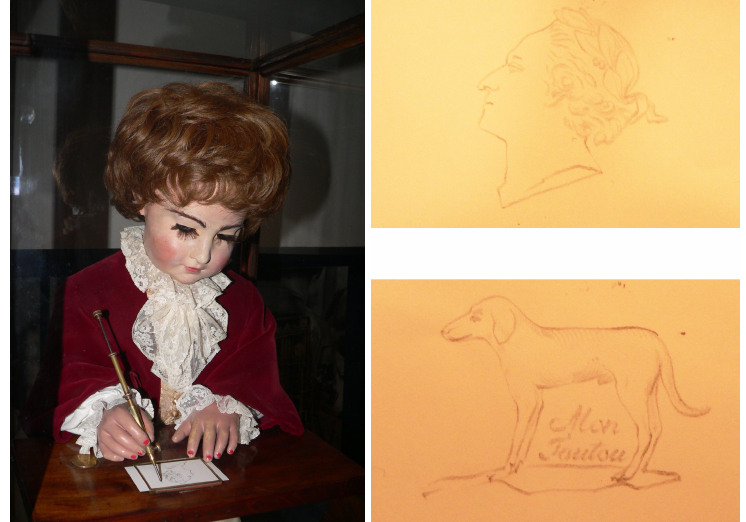
Figure 1. The “Artist” painting automaton by Jaquet-Droz ( Left , Rama (2005)) along with two of the four images that it can draw: a portrait of Louis XV ( Top Right ) and a drawing of a dog with “Mon toutou” written next to it ( Bottom Right ) Droz (ca.